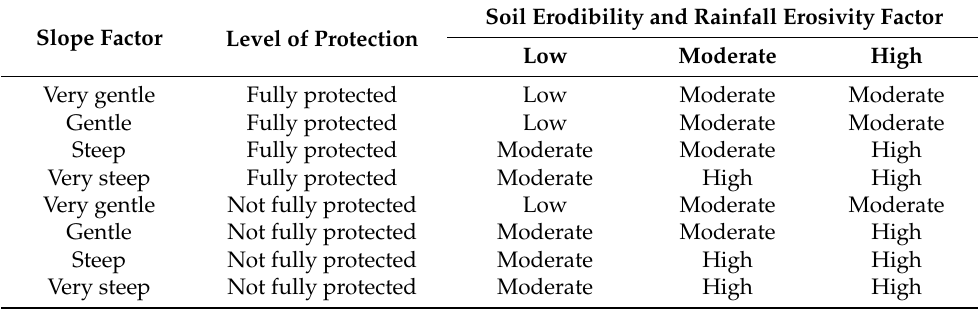
Table 8. Vulnerability levels associated with the soil erosion potential (ecological regeneration delay).